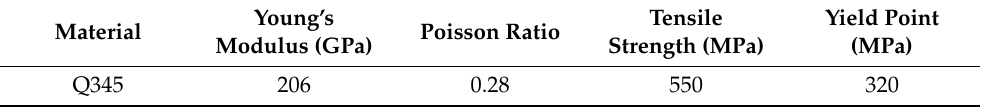
Table 7. Performance parameters of